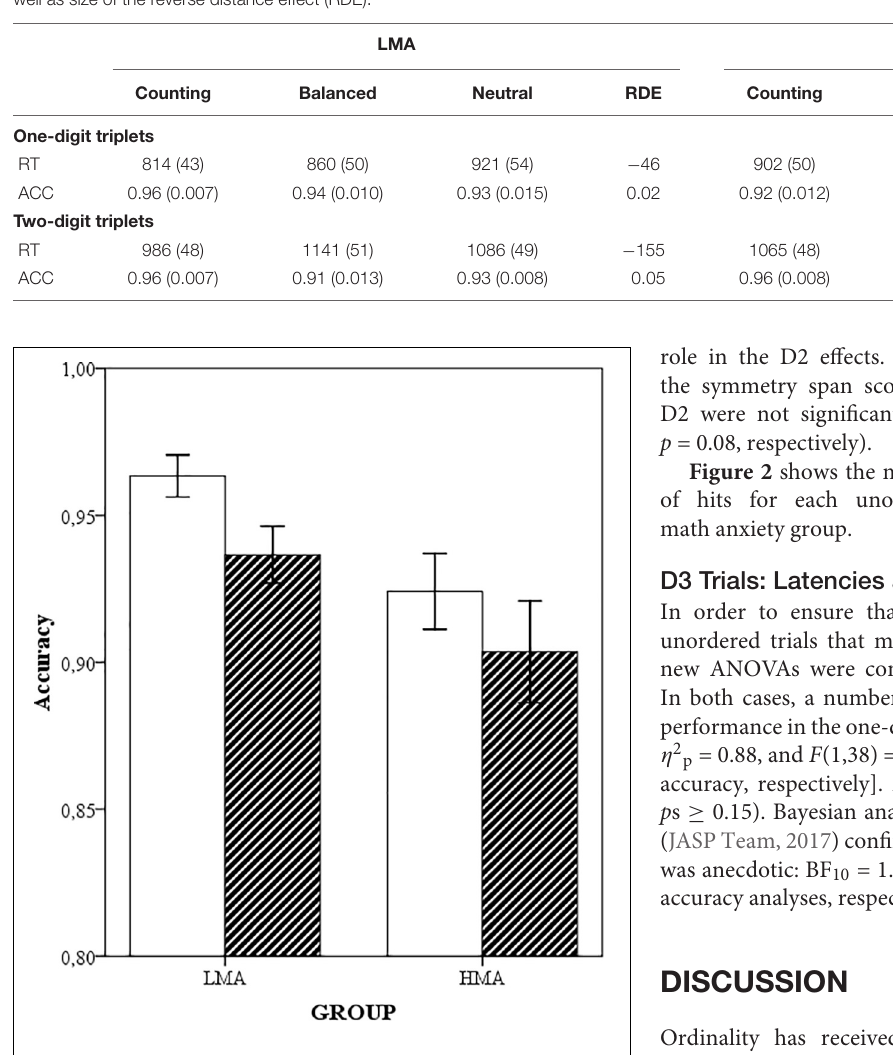
FIGURE 1 | Means and standard errors (in bars) for the proportion of hits of each math-anxiety group in the one-digit counting (white) and balanced (striped) ordered